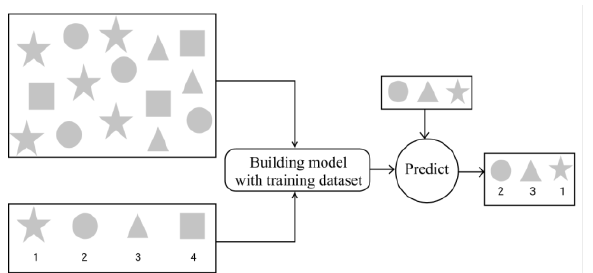
Fig. 1. Work Process of Supervised Machine